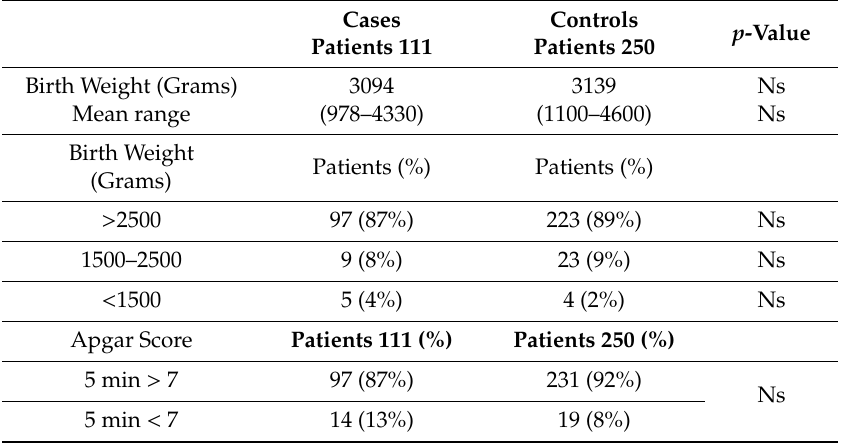
Table 4. Comparison of neonatal outcomes in women with endometriosis and